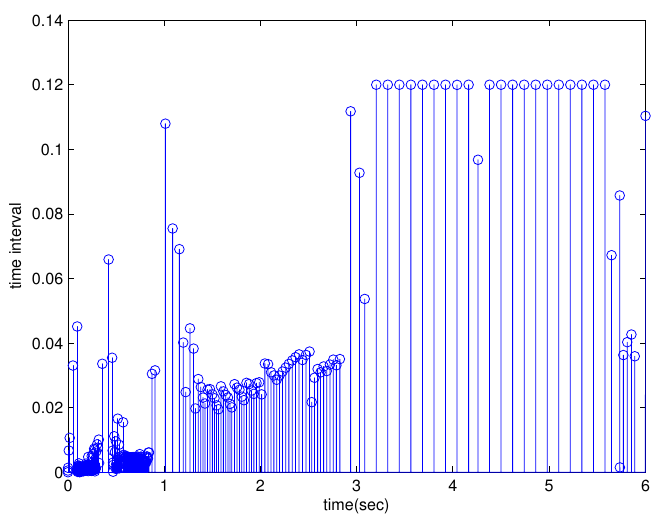
Figure 11. Evolution of the execution time